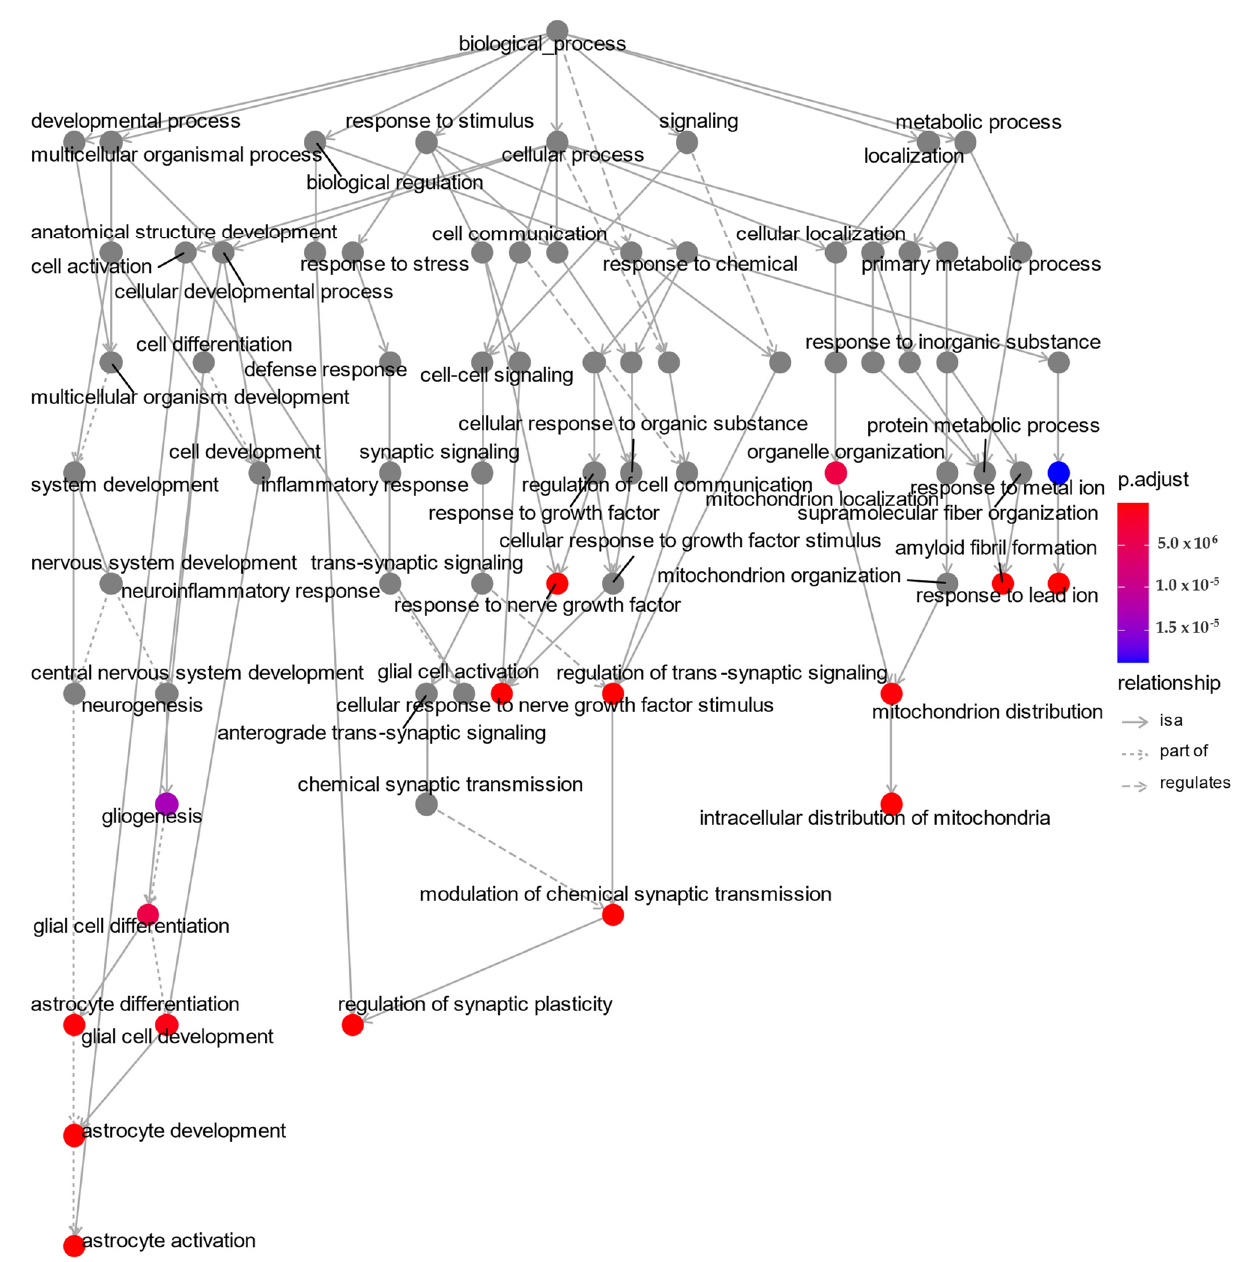
Figure 1. GO plot biological processes with dependencies between them based on enriched gene ontology terms for MAPT, APP, NRGN, and NPTXR. Top 10 biological processes were highlighted as color dots. This plot was produced in ClusterProfiler; p.adjust = the Benjamini–Hochberg adjusted p -value for the enriched ontology term.